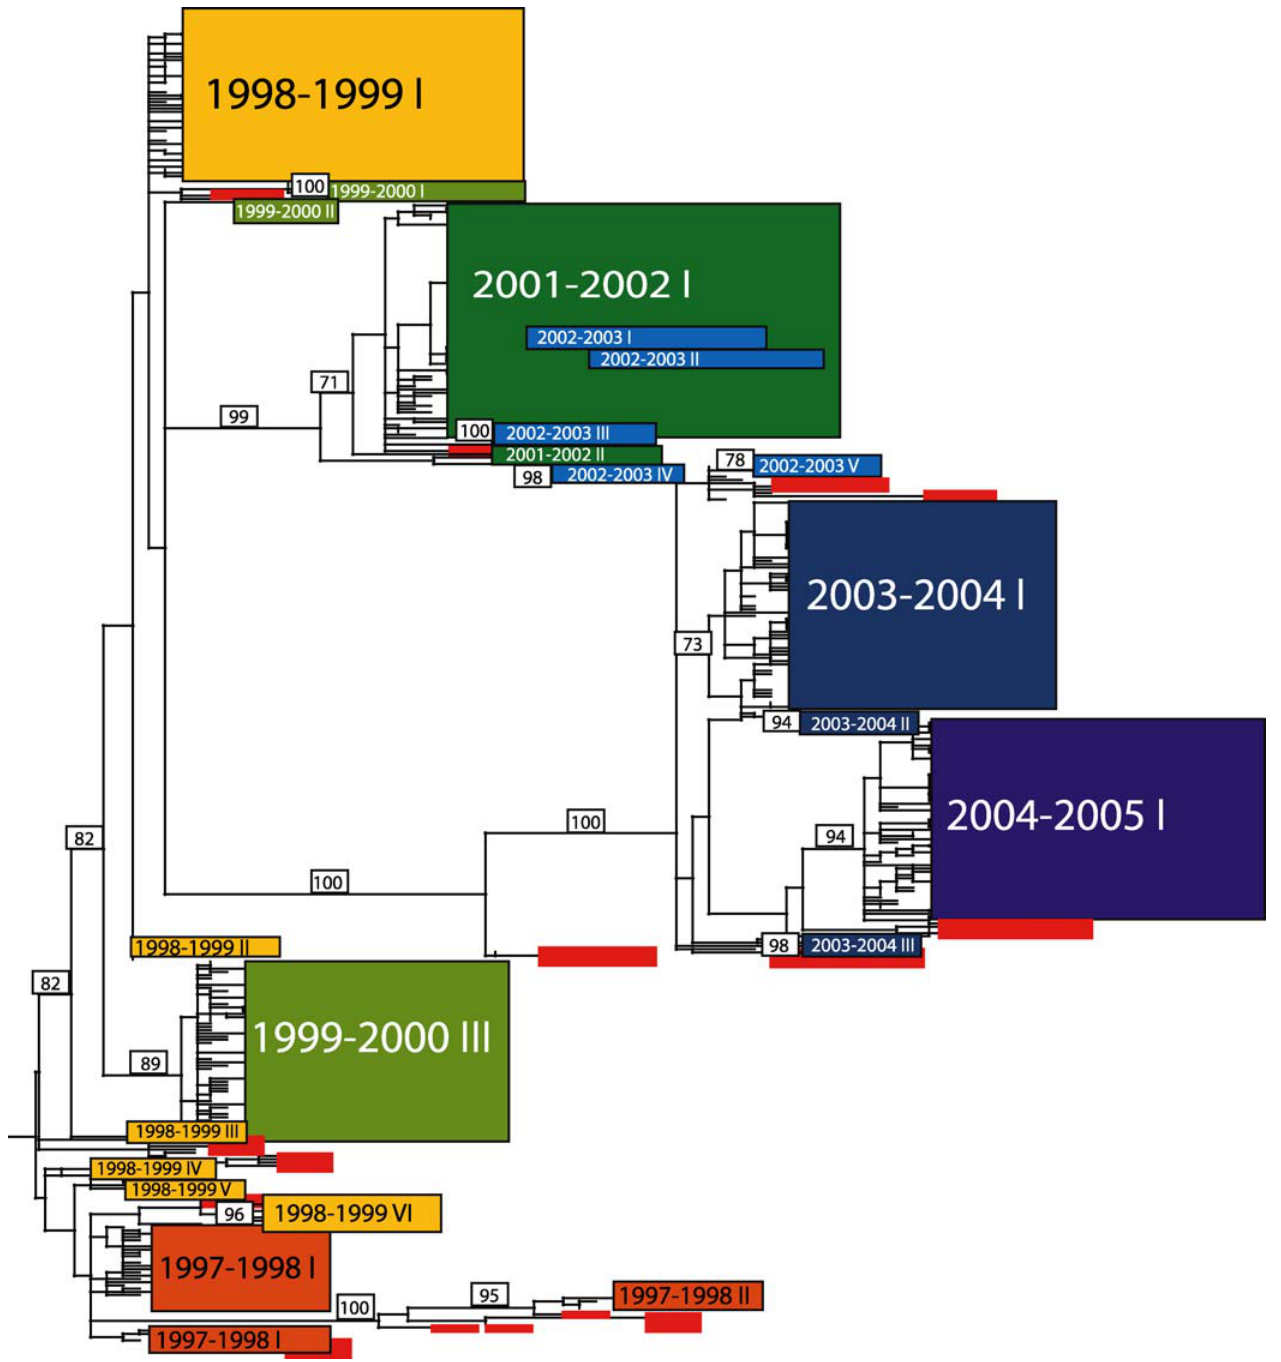
Figure 2. Phylogenetic Relationships of the HA Gene of Influenza Viruses Sampled from New York State and Globally during 1997–2005, Estimated Using an ML Method Rectangles represent clusters of related New York State isolates, with the size of the rectangle reflecting the number of isolates in the clade. Roman numerals indicate separate clades, with seasons colored as in Figure 1. Note that Roman numerals only denote the number of separate entries and do not correspond to the clade numbers given in Figure 1. Bootstrap values ( . 70%) are shown for key nodes. The tree is midpoint rooted for purposes of clarity, and all horizontal branch lengths are drawn to